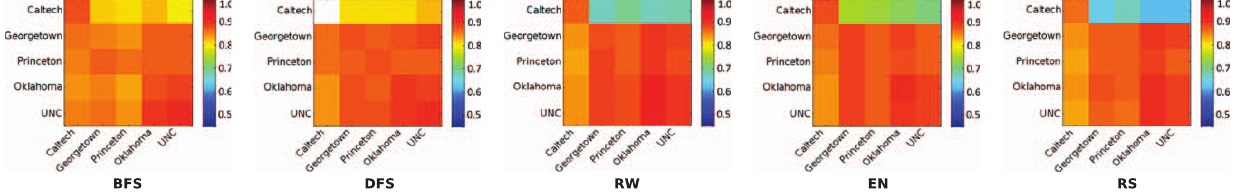
Figure 7. 1 R 1 cross-prediction accuracy. AUC values for each of the five member recruitment models at r ~ a ~ 0 : 5 . The y and x -axis show on which network the random forest was trained and tested, respectively. The white field indicates that there were too few edge samples to reasonably train the classifier.